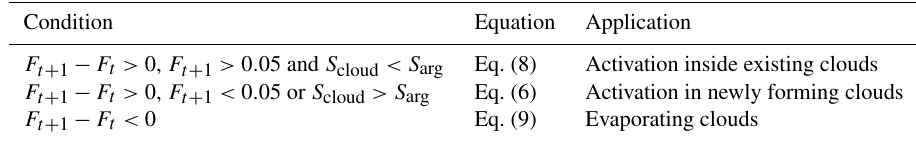
Table 2. Equations for activation to apply in different possible situations as described in the text.